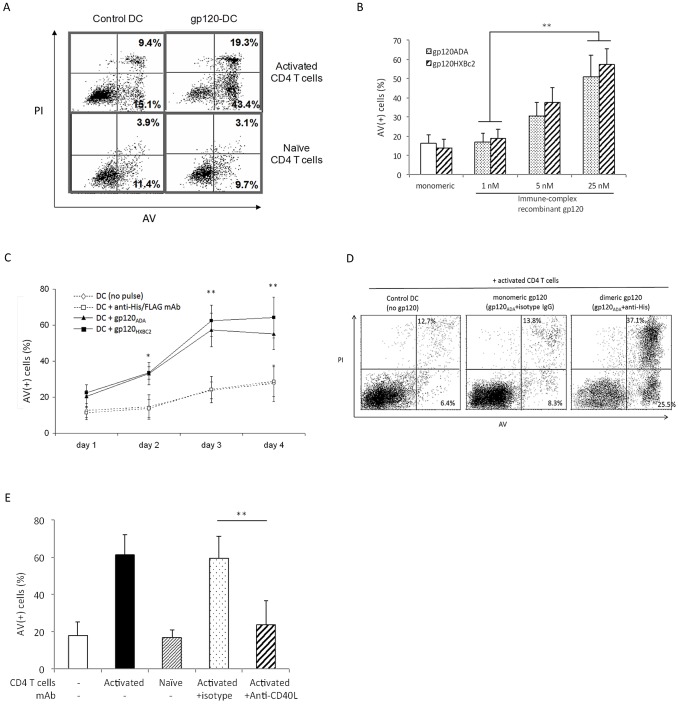
Cross-linked recombinant gp120 sensitizes moDC for CD40L-mediated apoptosis after co-culture with activated CD4 T cells.(A) moDC were treated for 24 h with anti-His mAb alone (control DC, left panels) or with 25 nM gp120ADA cross-linked with anti-His mAb (gp120-DC, right panels), and co-cultured with autologous activated (upper panels) or naïve (lower panels) CD4 T cells for 3 d. The moDC (Fig. S1) were analyzed for Annexin V (AV) and propidium iodide (PI) expression to assess the extent of apoptosis, as manifested by the percentage of the AV-positive [AV(+)] cells. Data are representative of 5 experiments. (B) Apoptosis of moDC was analyzed after treatment with different concentrations of cross-linked recombinant gp120ADA or gp120HXBc2 and co-culture with activated CD4 T cells for 3 d. DC treated with monomeric gp120 (not cross-linked with anti-His or anti-FLAG mAb) were used as a control. Data represent mean ± SD from 5 experiments; **p<0.01. The use of cross-linked recombinant gp120BAL gave similar results (not shown). (C) Apoptosis of moDC was analyzed after treatment with the indicated cross-linked recombinant gp120, or appropriate mAb controls, at the indicated time points after co-culture with activated CD4 T cells. Data represent mean ± SD from 5 experiments (data for anti-His and anti-FLAG controls were indistinguishable); *P<0.05 and **P<0.01 compared with control group (DC with no gp120 pulse or DC plus anti-His/FLAG Ab). (D) moDC were respectively not treated (Control DC), or treated with gp120ADA cross-linked with mouse IgG2a anti-His mAb (dimeric gp120-DC), or treated with cross-linked gp120ADA supplemented with isotype control mouse IgG (gp120-DC+isotype IgG), and subsequently co-cultured with autologous activated CD4 T cells for 3 days before AV/PI staining. Data are representative of 3 experiments. (E) moDC were treated with cross-linked gp120ADA and co-cultured for 3 d with autologous activated or naïve CD4 T cells, that had been pre-treated without or with 10 µg/ml isotype control or anti-CD40L mAb, before cell viability analysis. Data are expressed as mean ± SD from 5 experiments. **p<0.01.